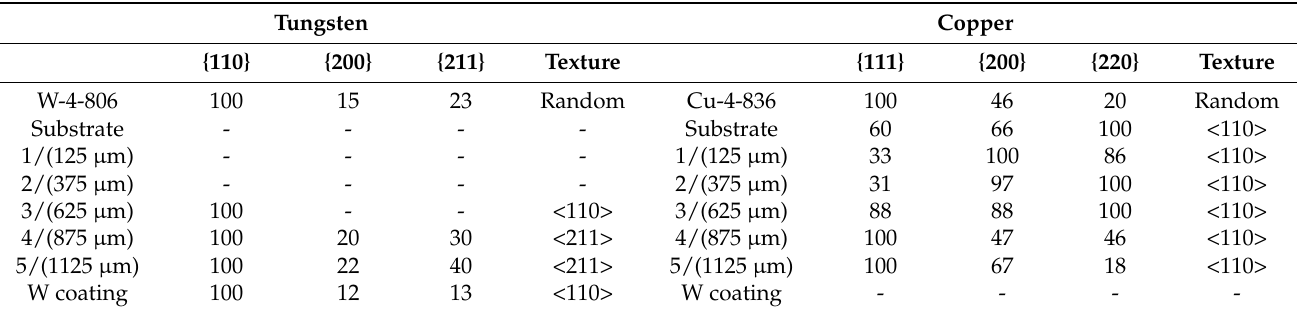
Table 2. The relative intensities of the W and Cu diffraction peaks in the XRD patterns collected from the CuCrZr substrate, W coating, and five different zones of the interlayer. The distance from the substrate of the interlayer’s irradiated zones is reported in brackets. For each zone, the central position of the X-ray spot is indicated.